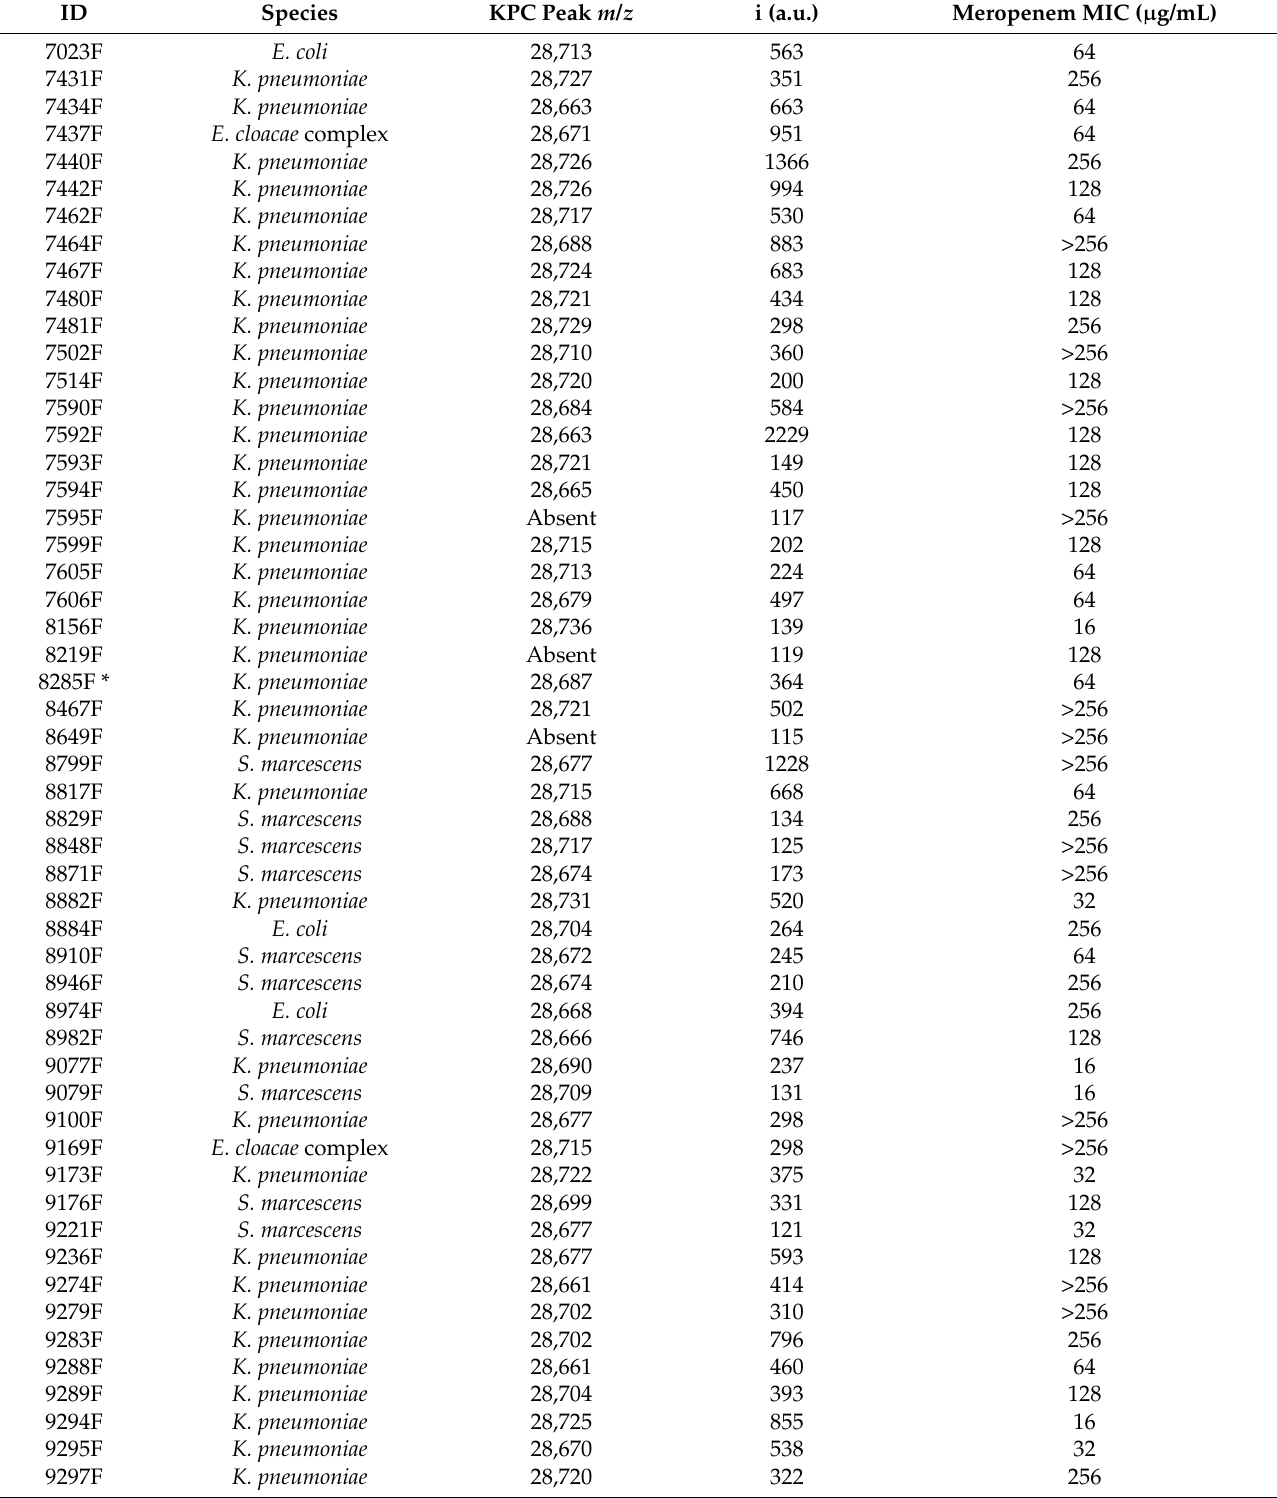
Table 1. Characteristics of bla KPC -positive bacteria used to inoculate blood cultures for KPC detection and results of spectra analysis by direct inspection and determination of